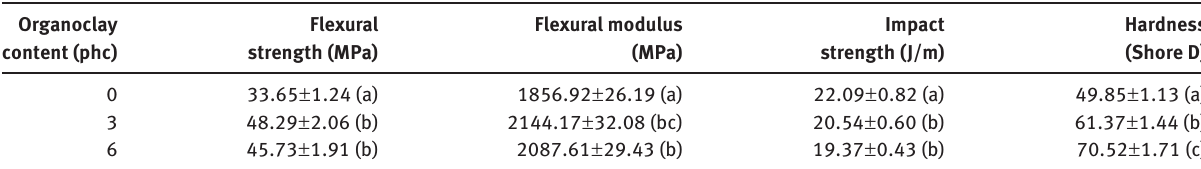
Table 3 Effect of organomodified montmorillonite content on mechanical properties of polypropylene/wood flour (PP/WF) composites exposed to brown-rot